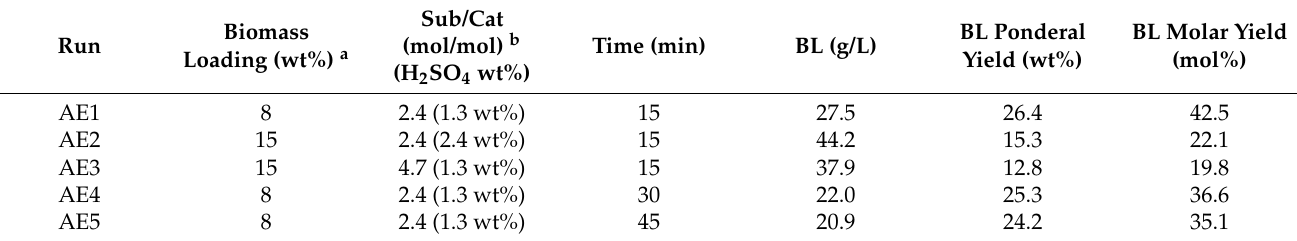
Table 5. Butanolysis experiments on wet E cardoon sample, adopting different biomass loadings and catalyst amounts. Experimental conditions: 190 ◦ C, H 2 SO 4 as catalyst, MW